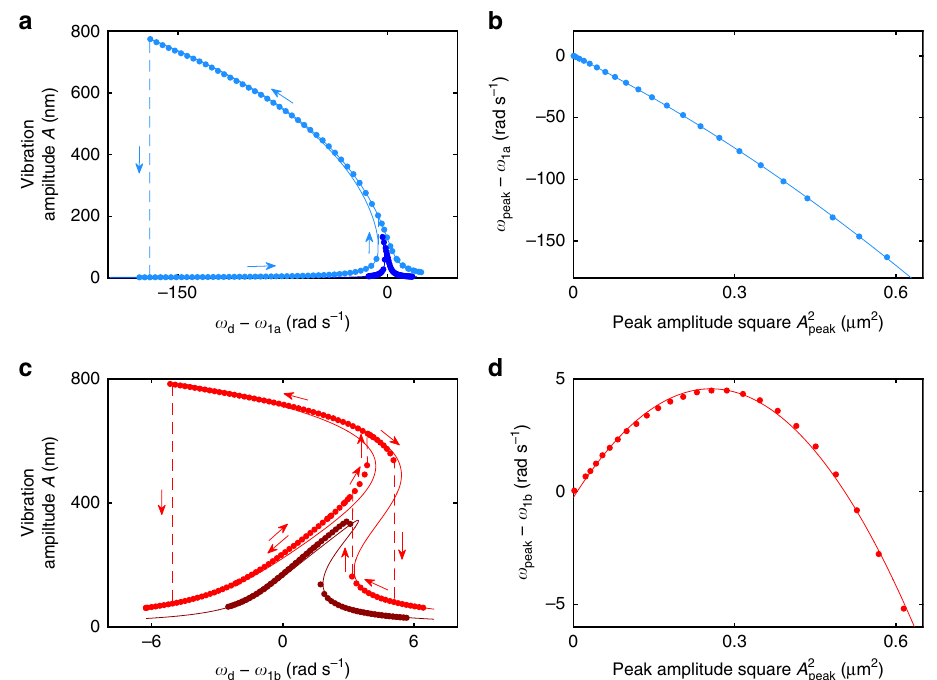
Fig. 2 Resonance curves and transformed backbone lines in the conventional nonlinear and zero-dispersion regimes. a At V dc = − 2.3 V, the resonator is in the conventional nonlinear regime. The resonance curve bends towards lower frequencies as the driving amplitude F ac is increased from 36.7 pN (dark blue) to 202 pN (blue). Measurement and theory (Supplementary Note 1) are represented by circles and lines, respectively. b Measured transformed backbone line (circles) showing the shift in ω peak relative to the natural frequency versus the squared vibration amplitude at the peak of the resonance curve as the driving amplitude increases. The solid line is a quadratic fi t. c At V dc = − 1.51 V, the resonator is in the zero-dispersion regime. The resonance curve for F ac = 75.2 pN (dark red) bends to higher frequencies. For F ac = 171 pN (red), the initial bending is also towards higher frequencies, but as the vibration amplitude further increases, the bending changes direction. d Accordingly, the transformed backbone line becomes non-monotonic and exhibits a maximum. The error bars are smaller than the dot size in all